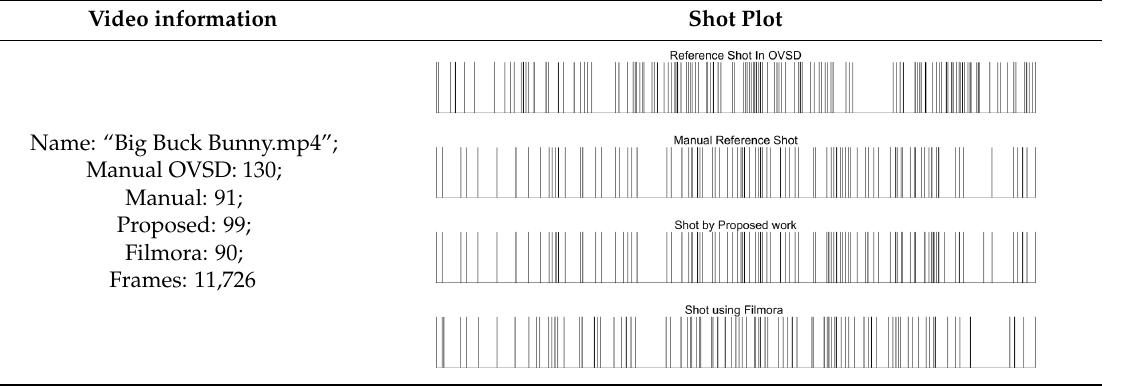
Figure 8. The representative frames from the three videos of the Open Video Scene Detection (OVSD) dataset. Table 9. Annotations of the OVSD dataset. Table 10. The examples of the SBD results.